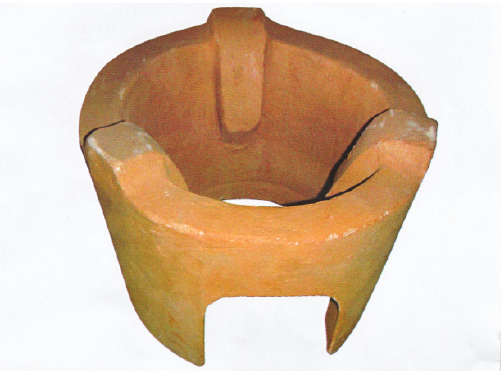
Figure 1. Upesi jiko, locally manufactured ceramic